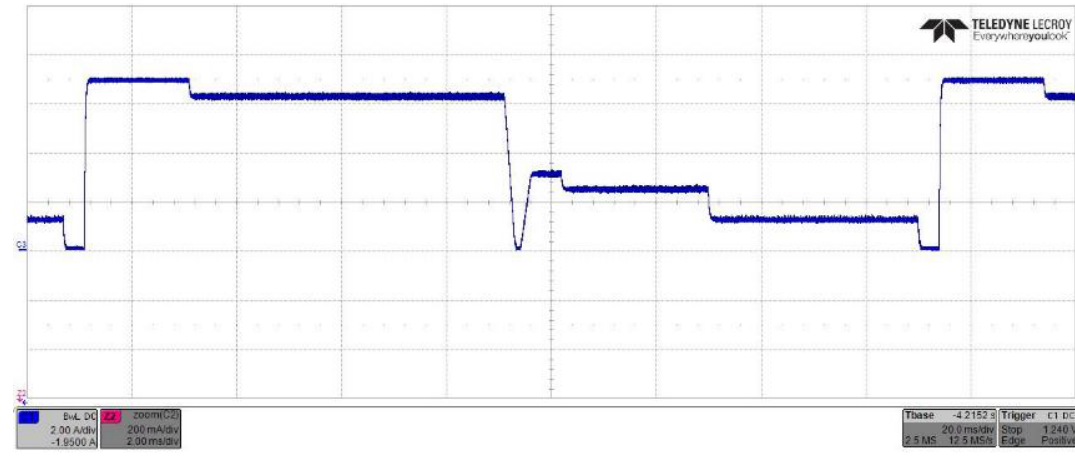
Figure 17. Response of the proposed SMC during step changes of the input current reference in a wide range of operation for a real EMA power profile.